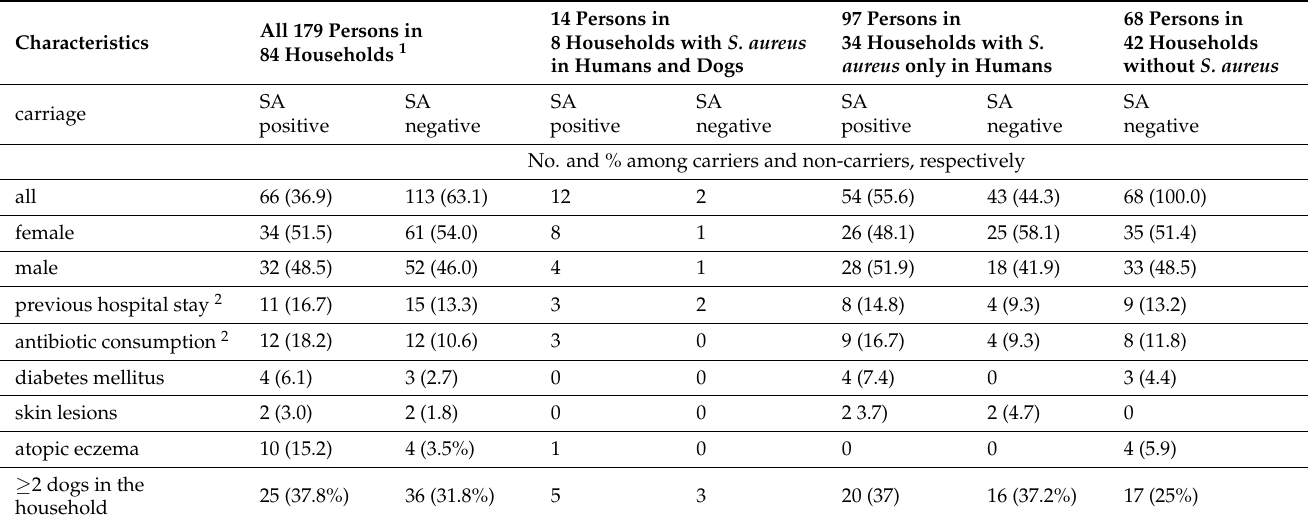
Table 1. Characteristics of humans and S. aureus (SA) carriage in 84 households.